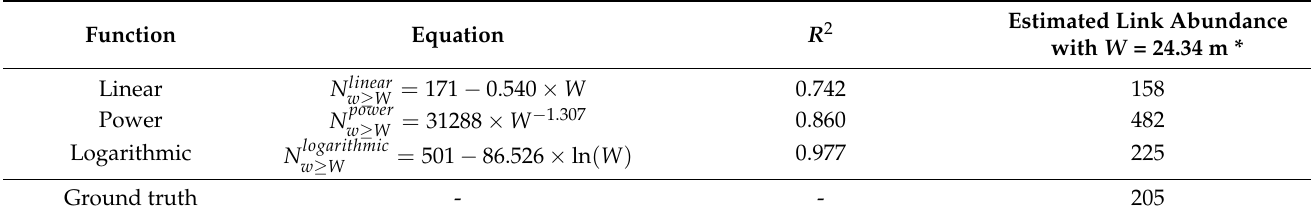
Table 6. The regression results of the width–abundance